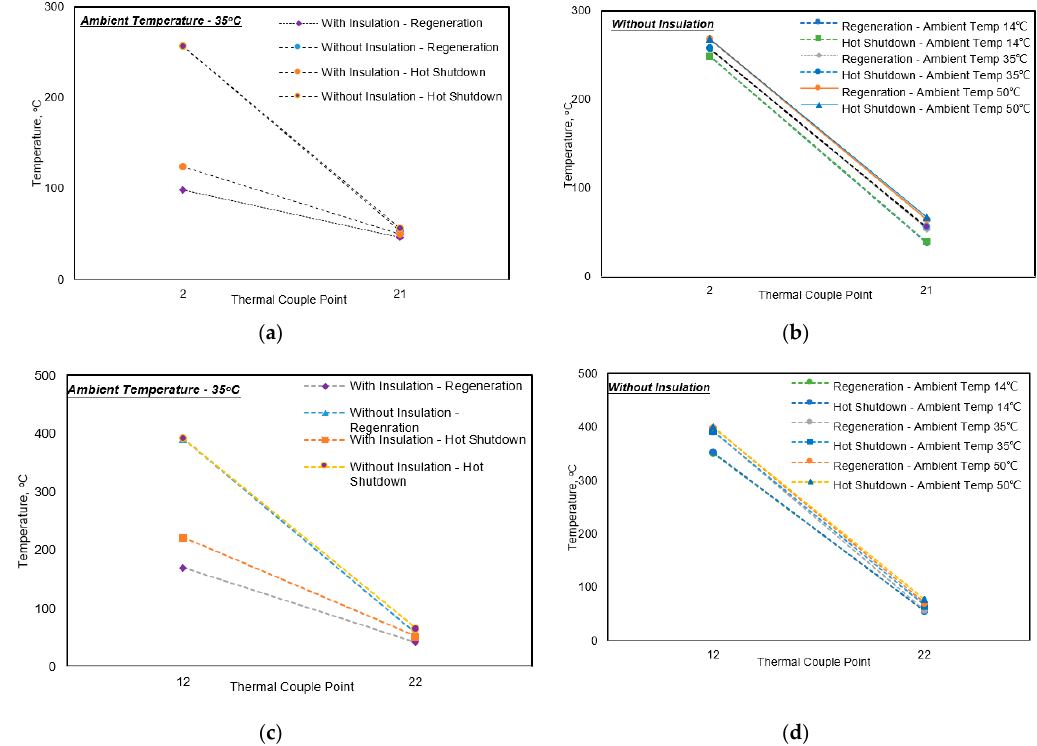
Figure 10. Radiated Impact from Aftertreatment on Neighboring Parts on Vehicle. ( a ) Radiated Impact from Aftertreatment Inlet to Vehicle Hood – Ambient Temperature (35 °C), ( b ) Radiated from Aftertreatment Inlet to Vehicle Hood—Ambient Temperature (35 ◦ C), ( b ) Radiated Impact from Impact from Aftertreatment Inlet to Vehicle Hood – Without Insulation, ( c ) Radiated Impact from Aftertreatment Inlet to Vehicle Hood—Without Insulation, ( c ) Radiated Impact from Aftertreatment Aftertreatment outlet to Vehicle Hood – Ambient Temperature (35 °C), ( d ) Radiated Impact from outlet to Vehicle Hood—Ambient Temperature (35 ◦ C), ( d ) Radiated Impact from Aftertreatment outlet Aftertreatment outlet to Vehicle Hood – Without Insulation. to Vehicle Hood—Without